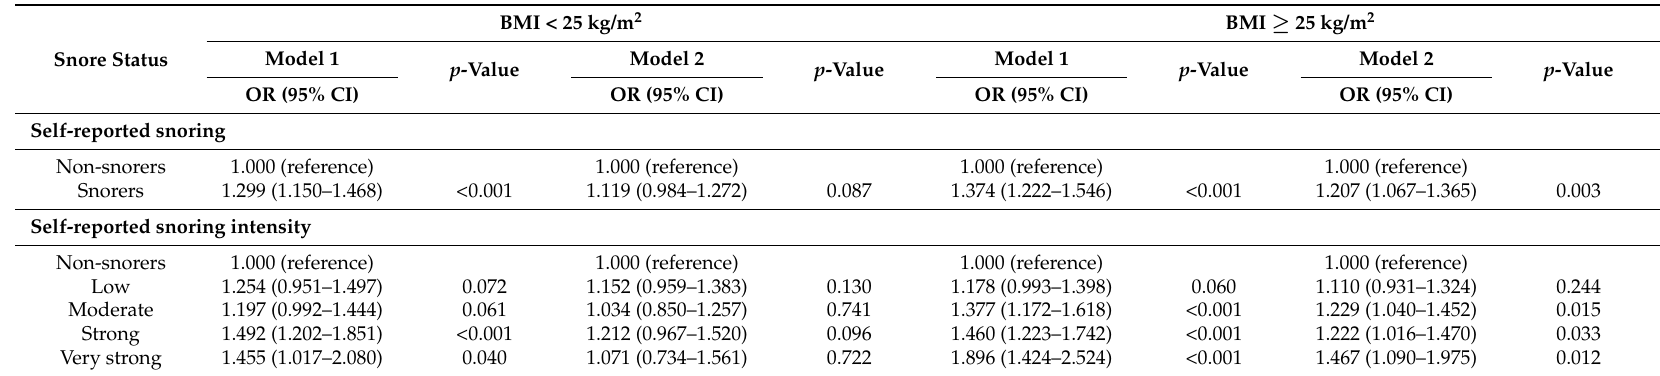
Table 2. Multivariable logistic regression analysis of the relationship between self-reported snoring, self-reported snoring intensity, and dyslipidemia according to participants with BMI < 25 kg/m 2 or BMI ≥ 25 kg/m 2